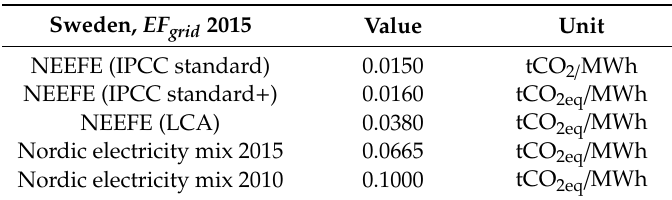
Table 1. Grid emissions factors EF grid in Sweden